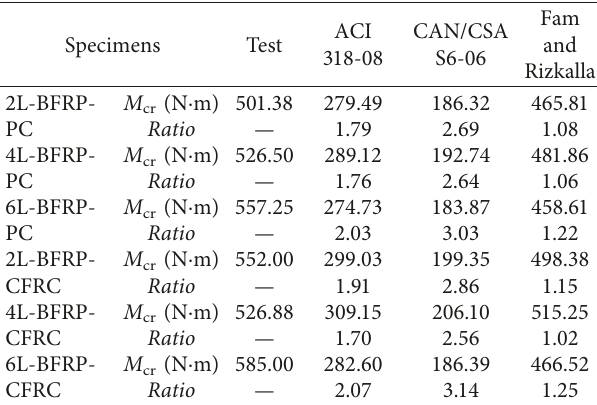
Table 4: Experimental and predicted cracking moments of BFRP- PC and